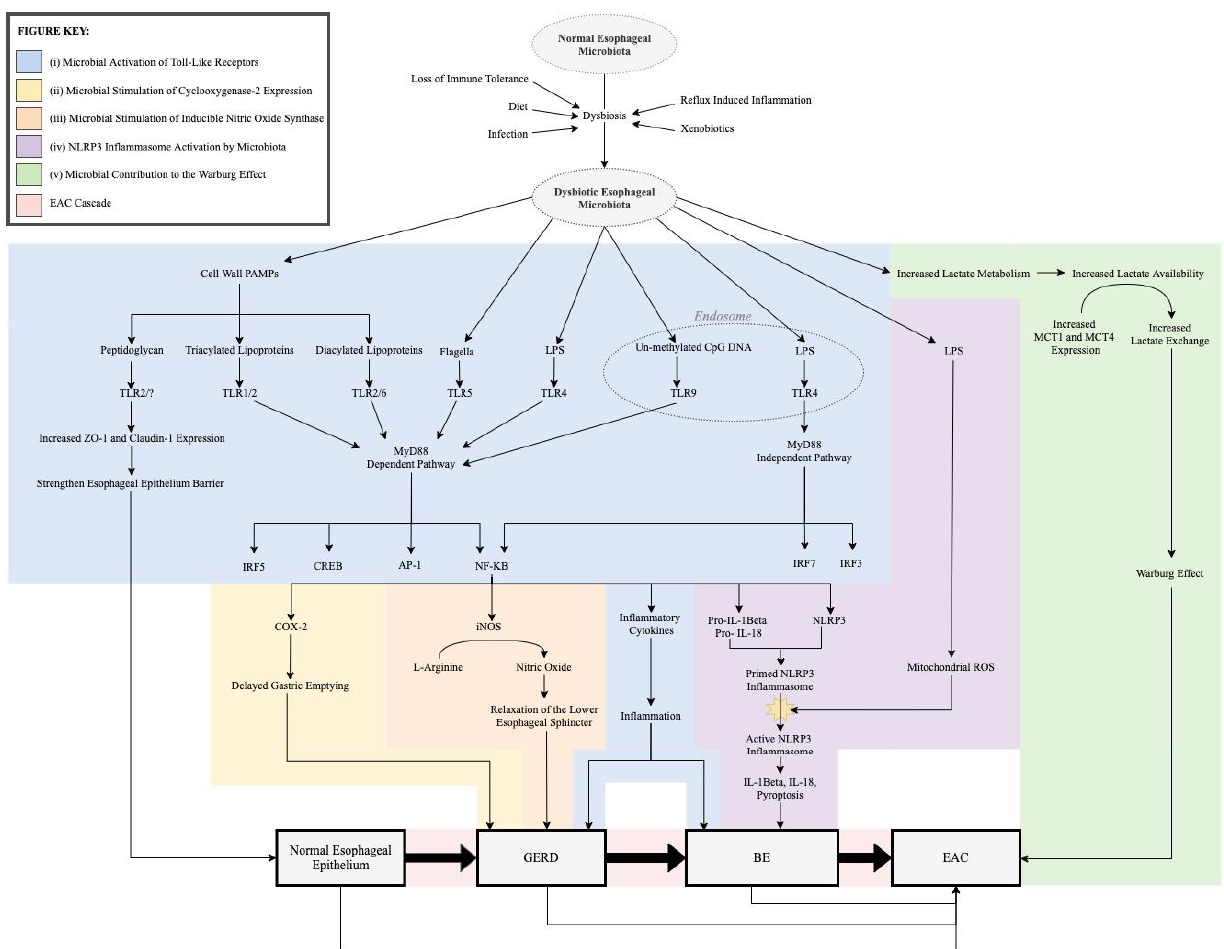
Figure 1. Molecular signaling in response to dysbiosis in EAC pathogenesis. The predominantly Gram-positive esophageal microbiome in the normal esophagus transforms through dysbiosis to a predominantly Gram-negative microbiome in the EAC cascade. The new microbiota can subsequently promote the pathogenesis of the EAC cascade through activation of toll-like receptors, stimulation of cyclooxygenase-2 expression, stimulation of inducible nitric oxide synthase, NLRP3 inflammasome activation, and contribution to the Warburg effect. PAMP = pathogen-associated molecular pattern; LPS = lipopolysaccharide; MCT = monocarboxylate transporter; TLR = toll-like receptor; ZO-1 = zonula occludens-1; MyD88 = myeloid differentiation primary response 88; IRF =interferon-regulator factor; CREB = cAMP-response element binding protein; AP-1 = activator protein 1; NF-kB = nuclear factor kappa B; COX-2 = cyclooxygenase-2; iNOS = inducible nitric oxide synthase; IL = interleukin; NLRP3 = nod-like receptor protein; ROS = reactive oxygen species; GERD = gastroesophageal reflux disease; BE = Barrett’s esophagus; EAC = esophageal adenocarcinoma.